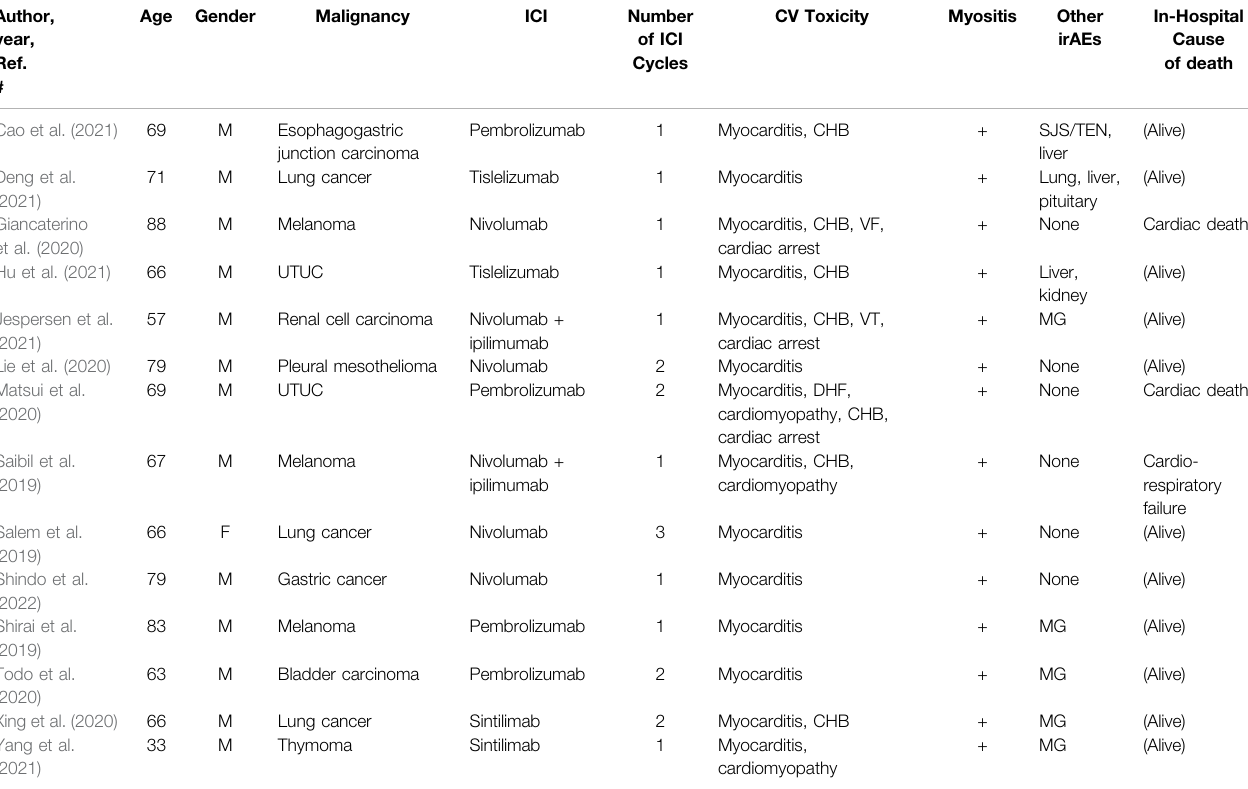
TABLE 3 | Clinical characteristics and prognosis of previously reported